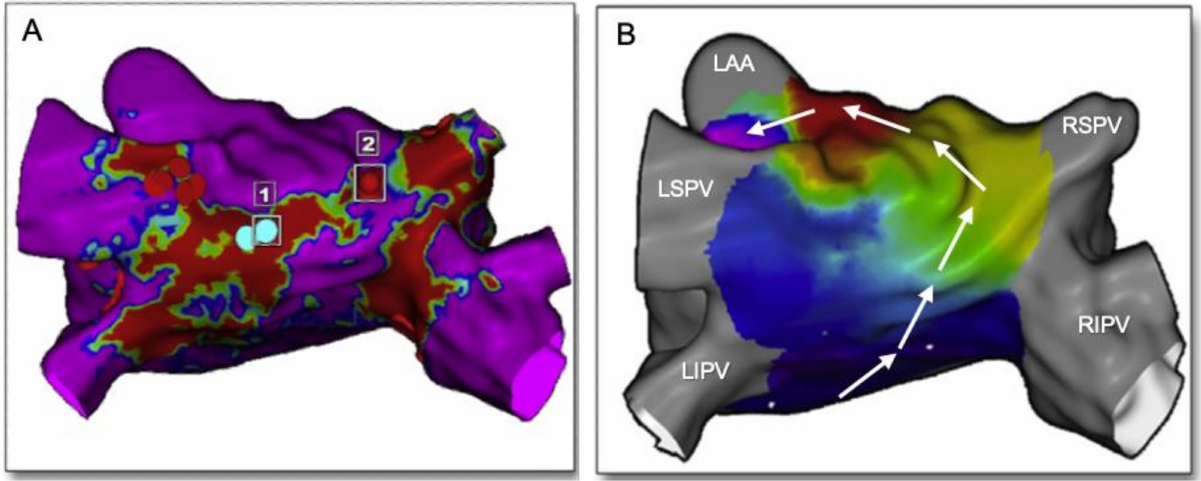
Figure 3. Usefulness of cardiac MRI in redo procedures of atrial fibrillation and atrial flutter ablation. ( A ): MRI-LGE of the left atrium in a patient with previous ablation of the roof presenting with atypical flutter. Red areas represent scar due to previous ablation (blue dots = 1). In point 2 (red dot), there is a portion of healthy tissue (purple) between the roof line and the RSPV. ( B ): Activation mapping during flutter with CARTO system depicts a circuit directed upwards along the posterior wall and crossing the gap identified at the MRI (white arrows). One-shot ablation in point 2 interrupted the roof-dependent atrial flutter. LAA: left atrial appendage, LSPV: left superior pulmonary vein, LIPV: left inferior pulmonary vein, RSPV: right superior pulmonary vein, RIPV: right inferior pulmonary vein. Modified from